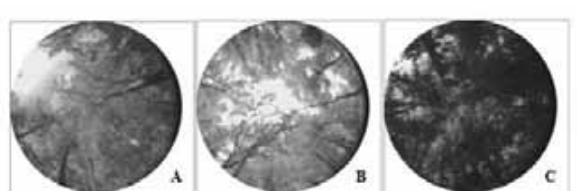
Figure 3. Hemispherical photographs collected during A) March, B) July and C) October of Sal in KNP. Model is applicable within NDVI range from 0.3 to 0.8 and ground LAI variations from 1-7 m 2 /m 2 . In present study LAI- NDVI model was used to study the spatial patterns of LAI distri- bution in the KNP. It was observed that sal is associated with higher LAI values as compared to other species mixed with Sal. The LAI values were observed at maximum for most of the forest types during October. The measured and model fitted monthly LAI values are given in Table 2. IRS-LISS-III derived LAI were compared with the global LAI Product of EOS-Terra MODIS in- strument. Overall good agreement (correlation= 0.79) was found between the LAI generated from LISS-III and MODIS data. Fig- ure 4 shows the inter comparison of IRS-LISS-III derived LAI with MODIS LAI product over